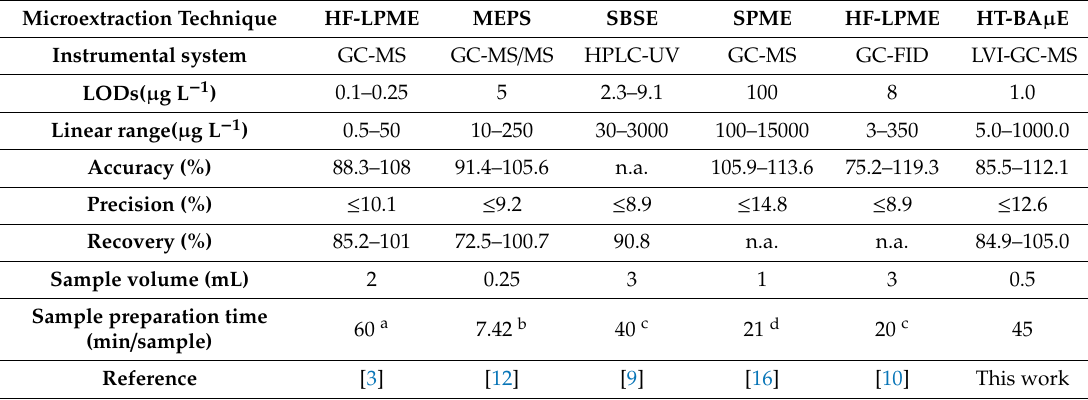
Table 3. Comparison of the proposed method with other previously reported microextraction approaches for the determination of KET and NKET in urine